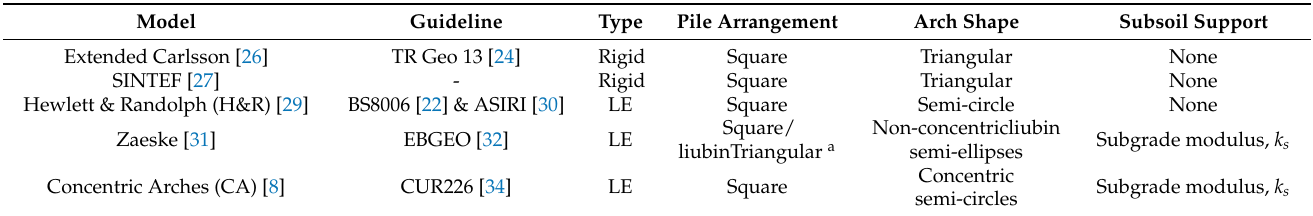
Table 3. Summary of the analytical models used for comparison and the guidelines (or standards) they are incorporated